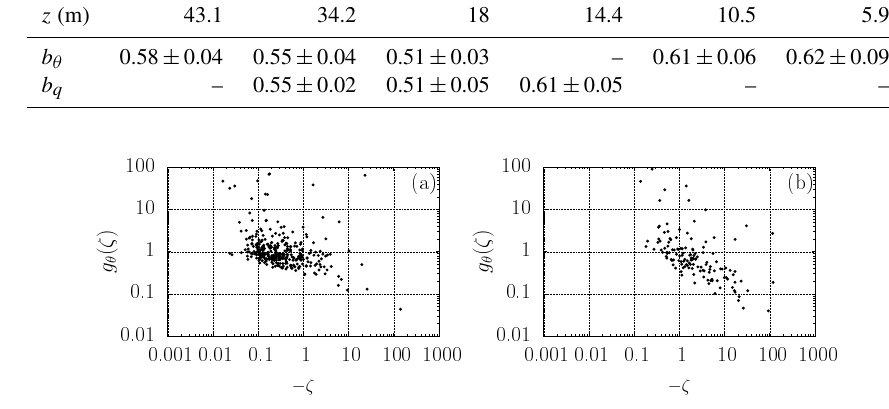
Figure 3. Inertial subrange similarity for temperature spectra: (a) 39.4m and (b) 81.6m.